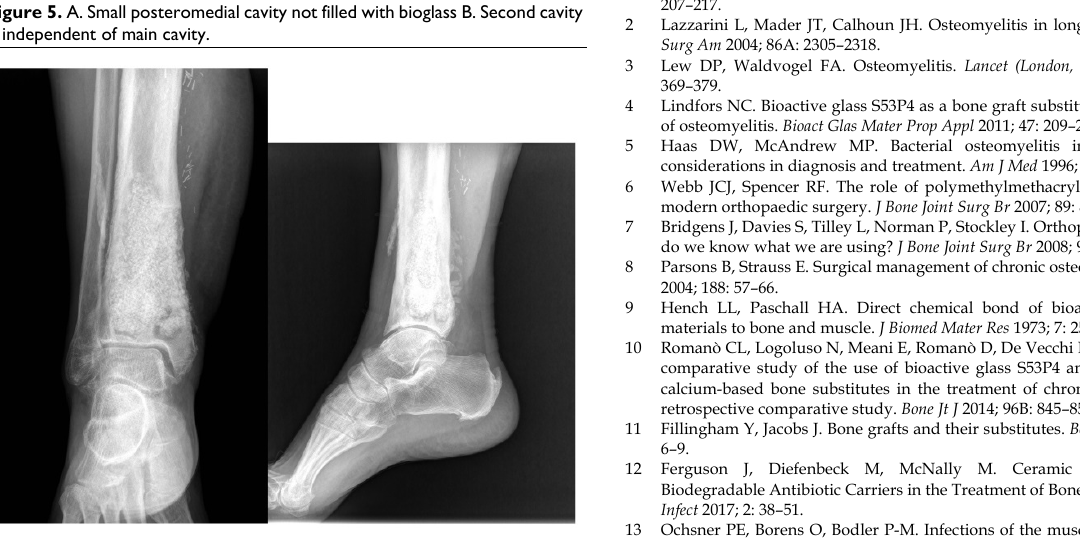
Figure 6. Correct bone void filling of all the cavities with bioglass.